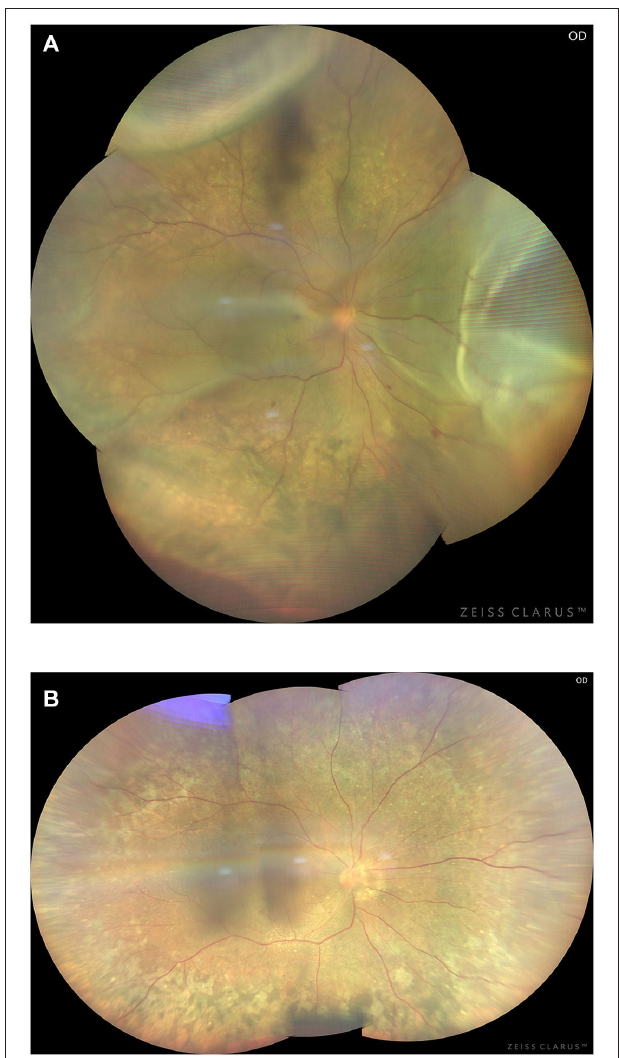
FIGURE 13 | Preoperative (A) and 3-month postoperative (B) retinal images (montage, CLARUS 500; Carol Zeiss) of an eye with type 2 UES. Note retinal detachment involving the macula and choroidal swelling extending posterior to the equator in the superior quadrants (A) . Total resolution of the retinal detachment and choroidal swelling (B) was achieved 3 months after quadrantic lamellar-sclerectomy with sclerostomy in the inferior quadrants.